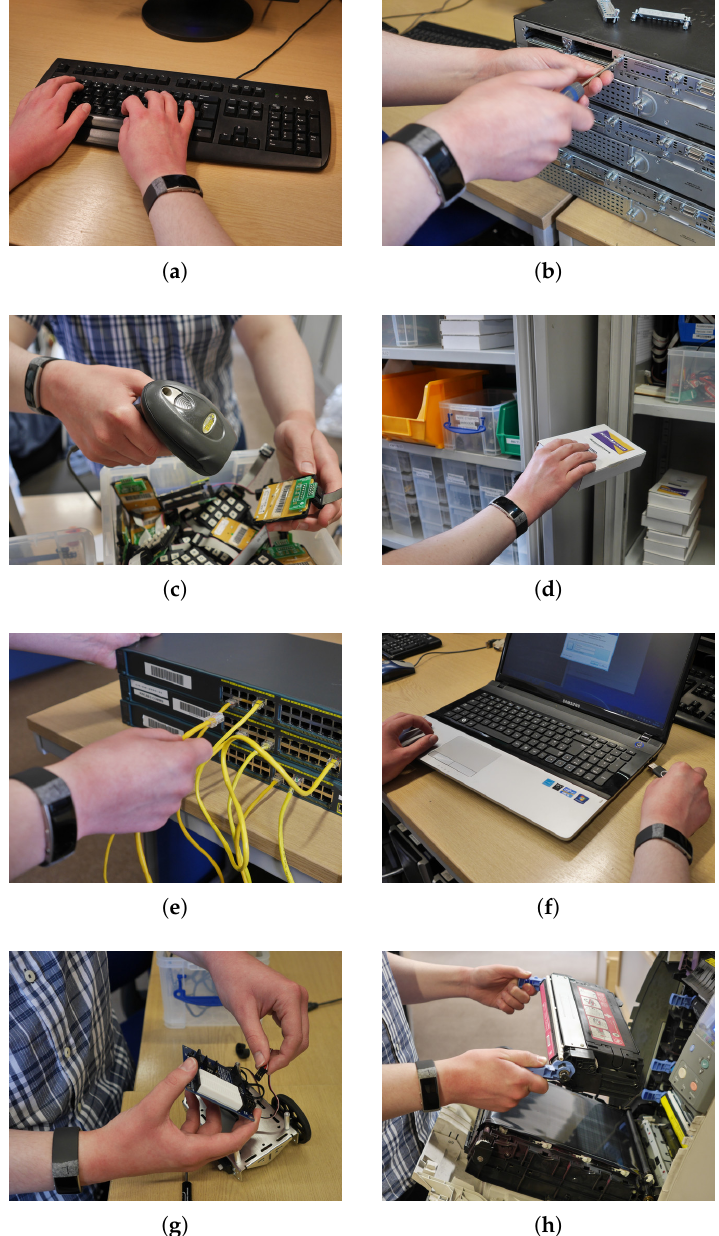
Figure 6. The activities performed by the participants in our laboratory. ( a ) Typing; ( b ) servicing; ( c ) scanning; ( d ) relocating; ( e ) patching; ( f ) installing; ( g ) assembling; ( h )